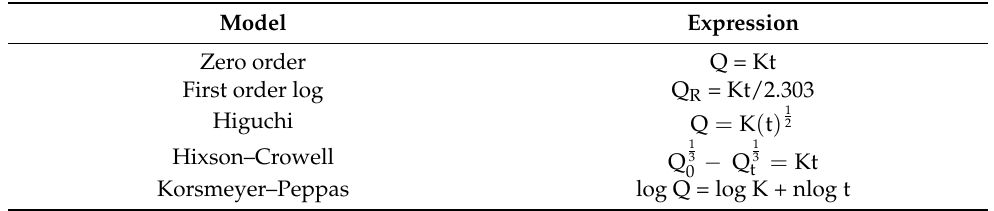
Table 2. Models for drug release kinetics.